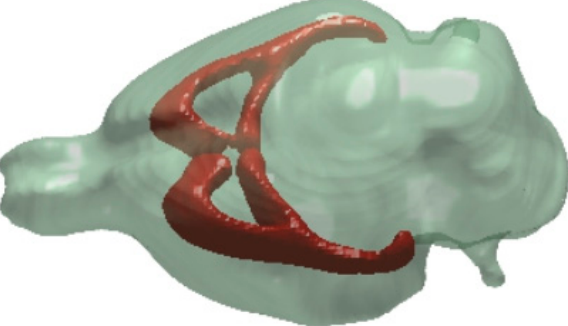
Figure 4. A representative 3D image showing the main commissural white matter pathways (brown) of the rat brain.